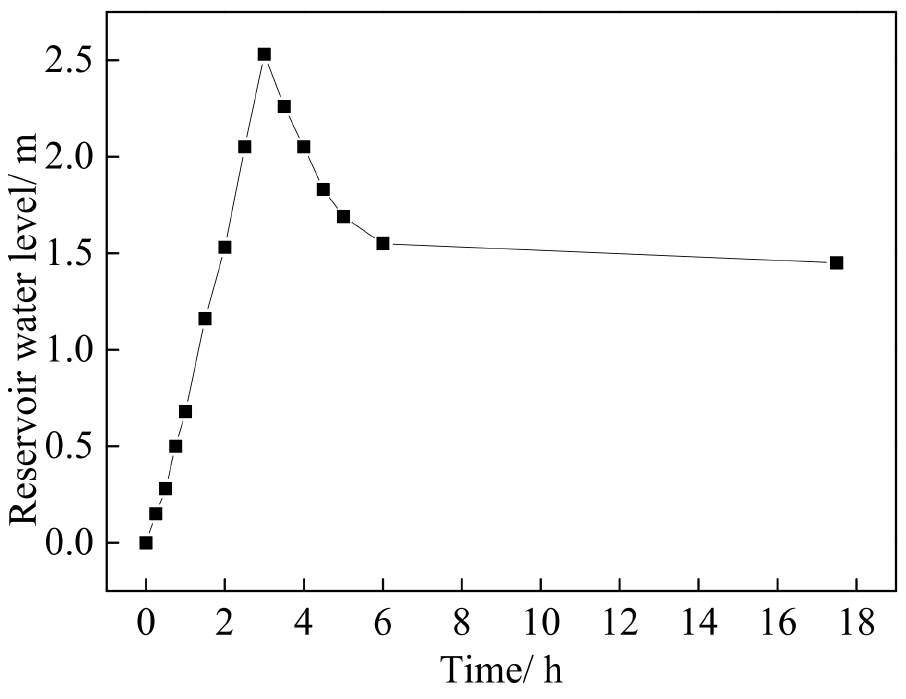
Figure 8. Relationship between reservoir water level and